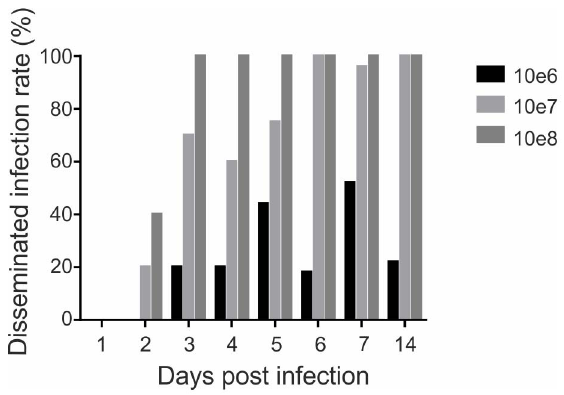
Figure 3. CHIKV infection in Ae.aegypti . Disseminated infection rates (DIR) were determined by estimating the proportion of mosquitoes with disseminated infection (where infection has spread beyond the midgut and led to infection of secondary organs including the salivary glands) among tested females. Three viral titers were tested: 10 6 , 10 7 and 10 8 PFU/ml.